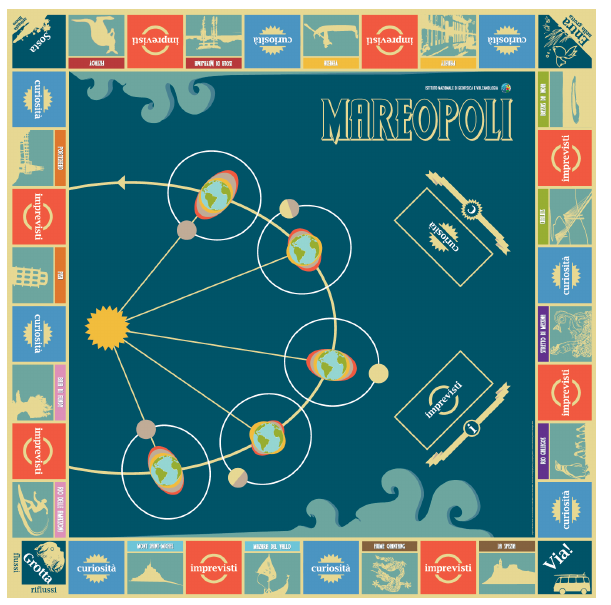
Figure 6. Mareopoli game. The board and the curiosity, unforeseen and city cards explain the tide formation and the evolution of tide theory (illustration made by Francesca di Laura from INGV Labo- ratorio di Grafica e Immagine, graphic office).